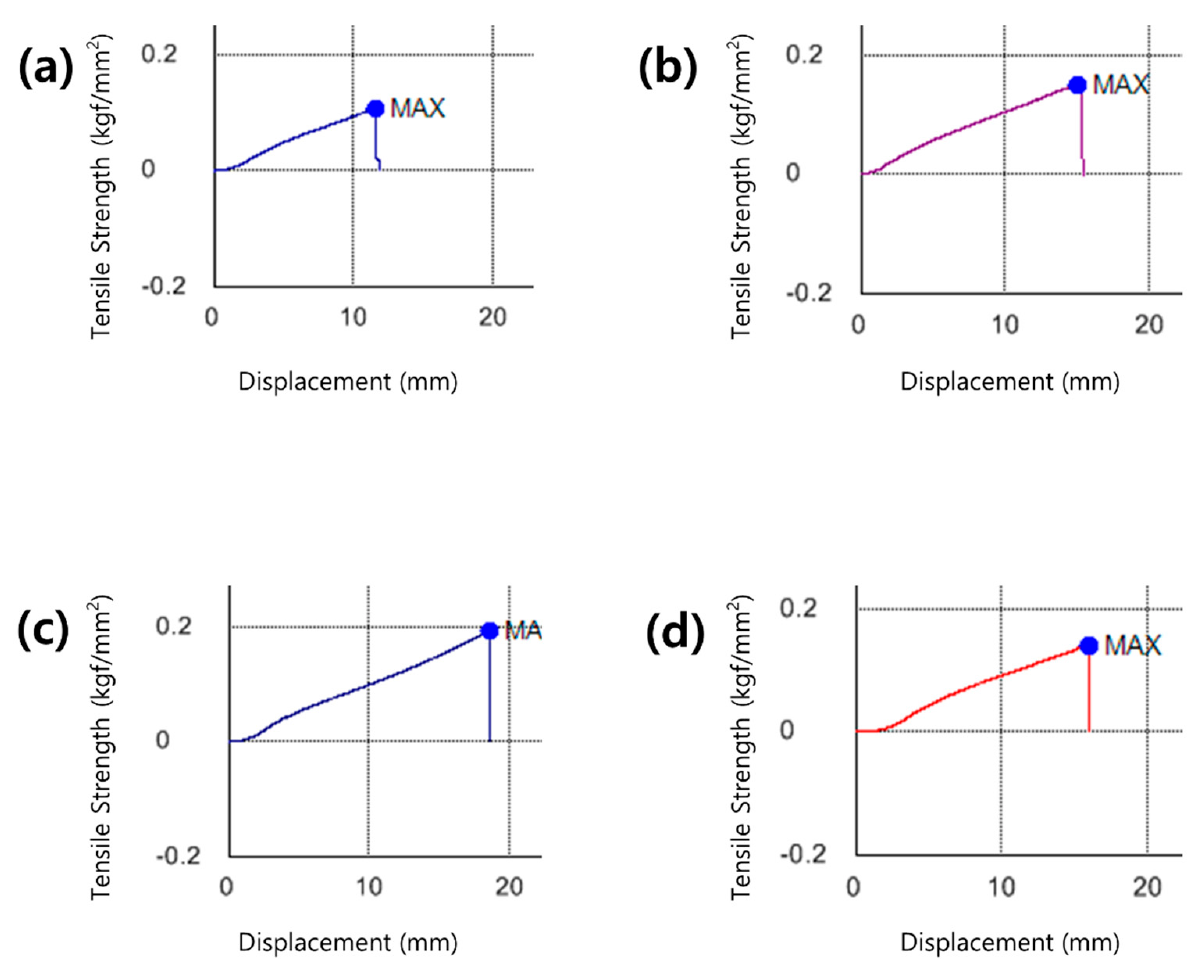
Figure 3. Tensile strength image of ( a ) P sample, ( b ) PN sample, ( c ) PNM3 sample and ( d ) PNM5 sample.